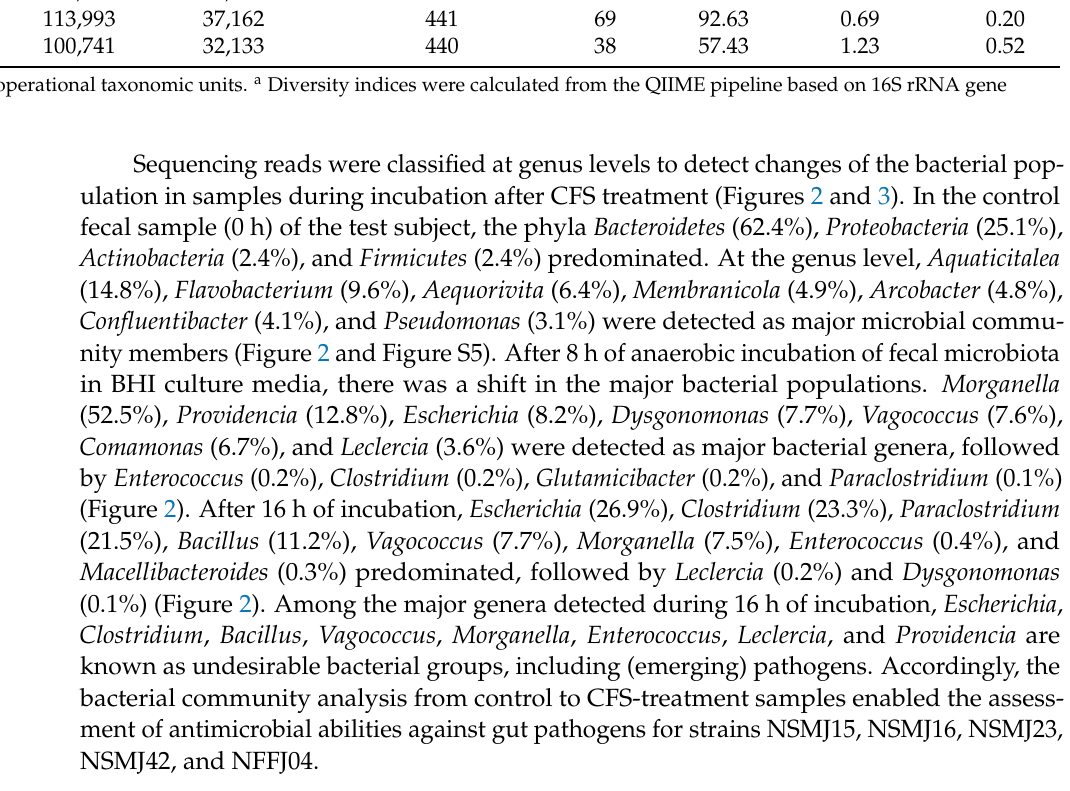
(Figure S4). In the cases of NSMJ16-, NSMJ23-, and NFFJ04-CFS, there was no significant difference of growth kinetics compared to the non-treatment (control) sample.